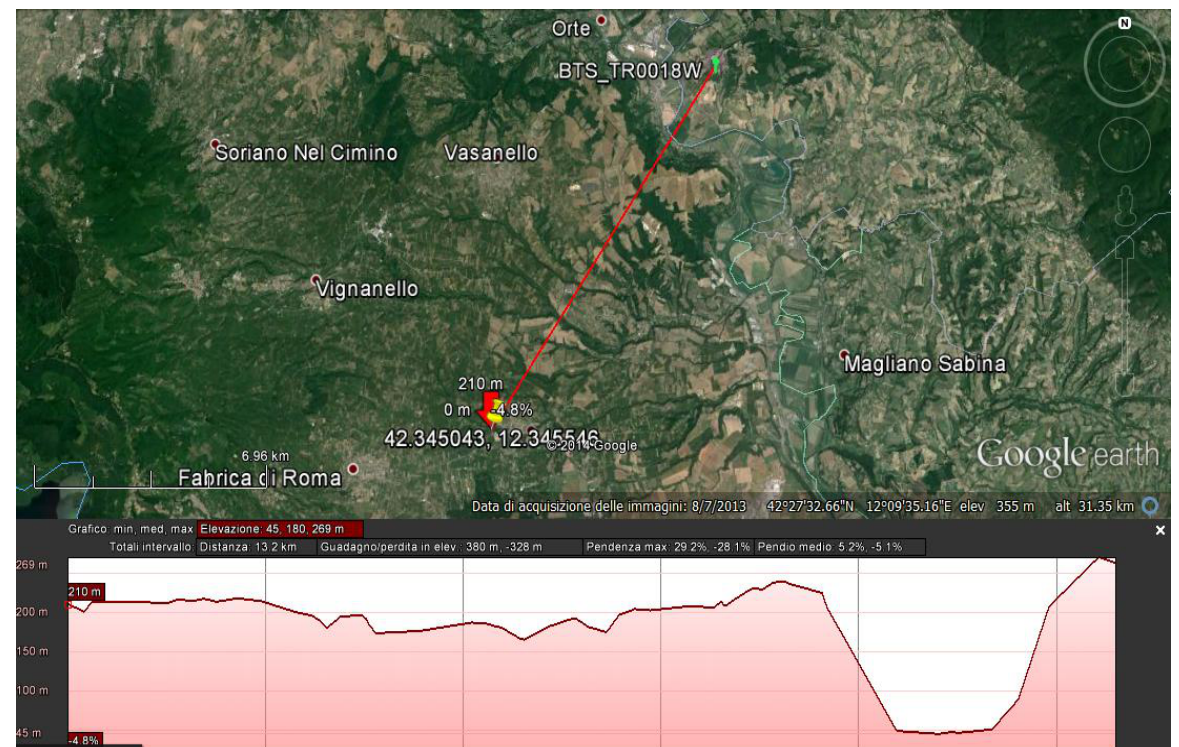
Figure 6. Distance between the site and the BTS with elevation